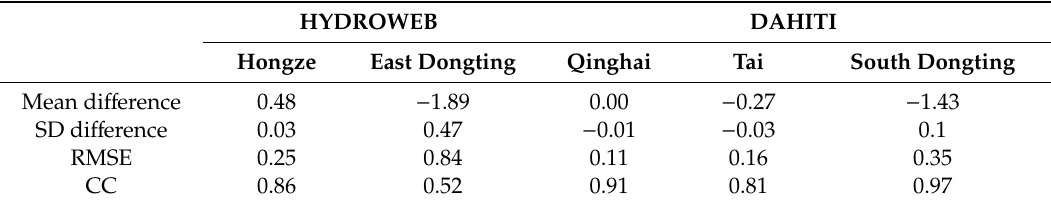
Table 2. Evaluation results of the Database for Hydrological Time Series of Inland Waters (DAHITI) and HYDROWEB water levels by in situ gauge data. HYDROWEB DAHITI Hongze East Dongting Qinghai Tai South Dongting Mean di ff erence